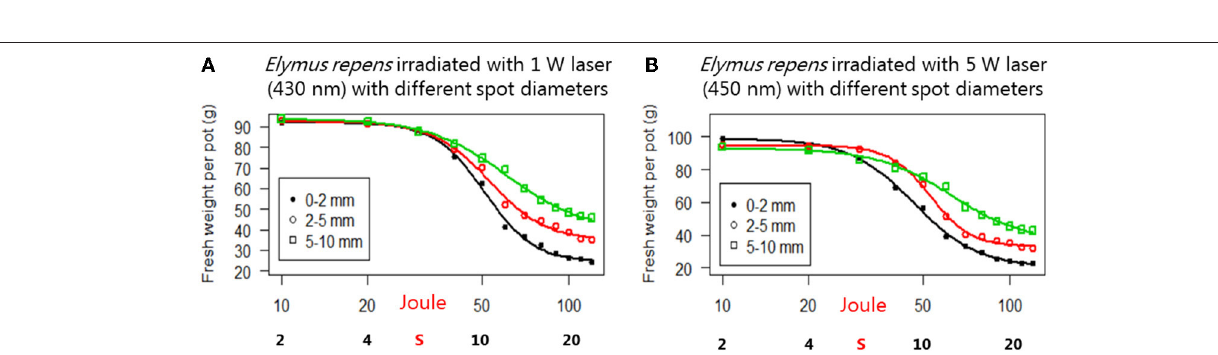
FIGURE 1 | Dose-response experiment with a 50W fiber laser. Chenopodium album L. plants were exposed at the two and six leaf stage to various pulse lengths ( n = 3) (modified from Andreasen et al., 2021).